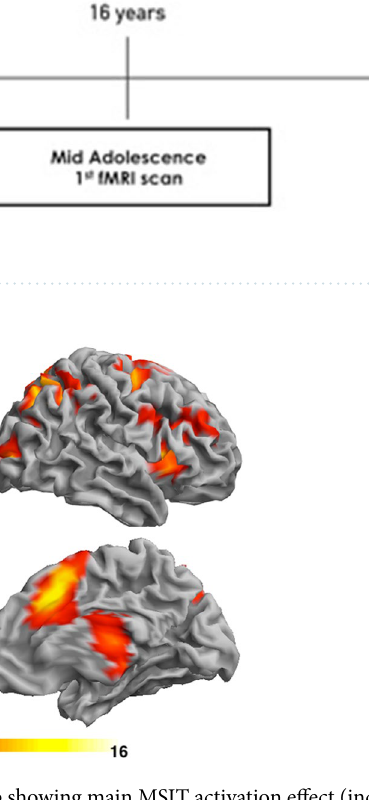
Figure 2. Statistical parametric map showing main MSIT activation effect (incongruent > congruent) across both time points. The colour bar represents standardised Z-scores. Right hemispheres are shown on the right. Results are corrected for multiple comparisons ( p < .05; see Methods” for more